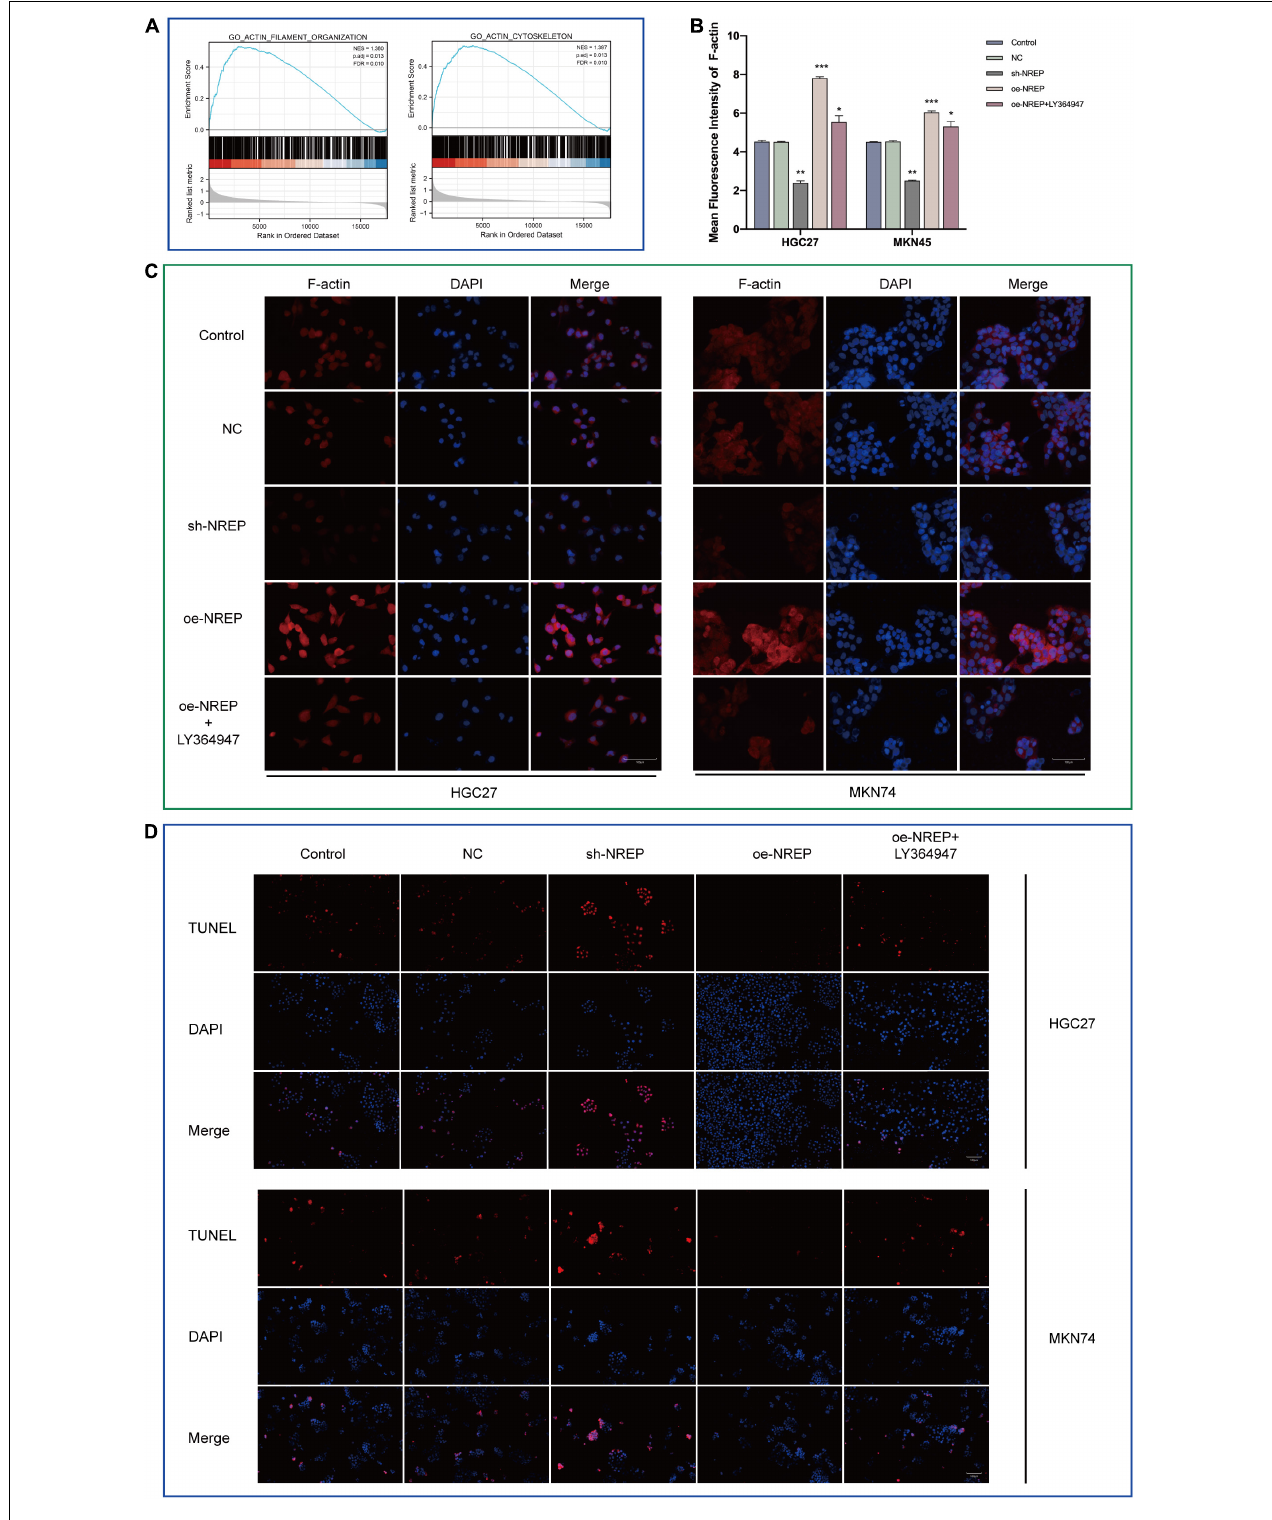
FIGURE 5 | Relationship between NREP and F -actin cytoskeleton and cell apoptosis. (A) Gene Set Enrichment Analysis (GSEA) of NREP. (B) Immunofluorescence intensities. (C) F -actin levels in gastric cancer (GC) cells (control cells and GC cells transfected with the NC, sh-NREP, and oe-NREP constructs) treated with 5 µ M LY364947 detected using immunofluorescence staining (magnification, × 400). (D) Apoptosis assessed using a TUNEL assay (TUNEL-positive cells indicated in red; magnification, × 200). (* P < 0.05, ** P < 0.01, *** P < 0.001).